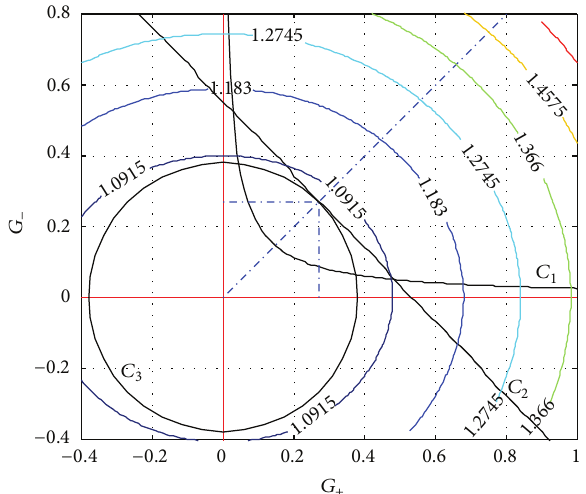
Figure 13: Stable regions of the controller in the (𝐺 + - 𝐺 − ) space: the hyperbolic-like curve 𝐶 1 is the boundary keeping the topological typeoftheequilibriumelliptic;theline-likecurve 𝐶 2 istheboundary keeping the Floquet multipliers lying on the unit circle in the complex plane; the closed curves labeled by numbers are contour curves of theaveraging values of 𝜅 ; thecircle 𝐶 3 is theapproximation of the contour curve.